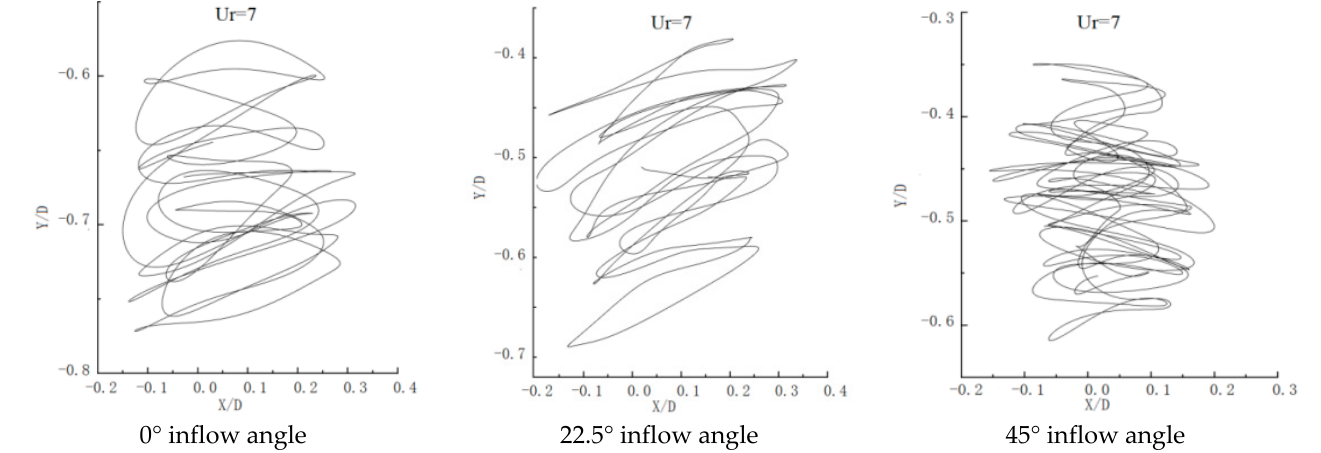
Figure 5. The trajectories of floating bodies with three inflow angles in XY plane.